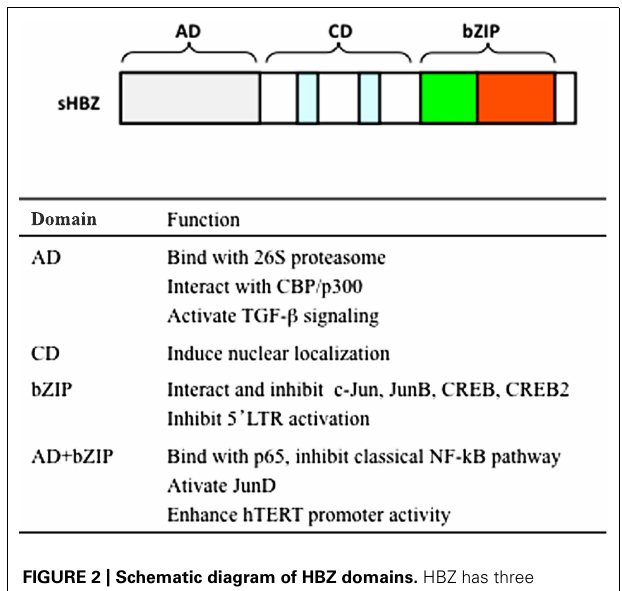
FIGURE 2 | Schematic diagram of HBZ domains. HBZ has three domains: activation domain (AD), central domain (CD), and basic ZIP domain (bZIP). Functions of each domain are